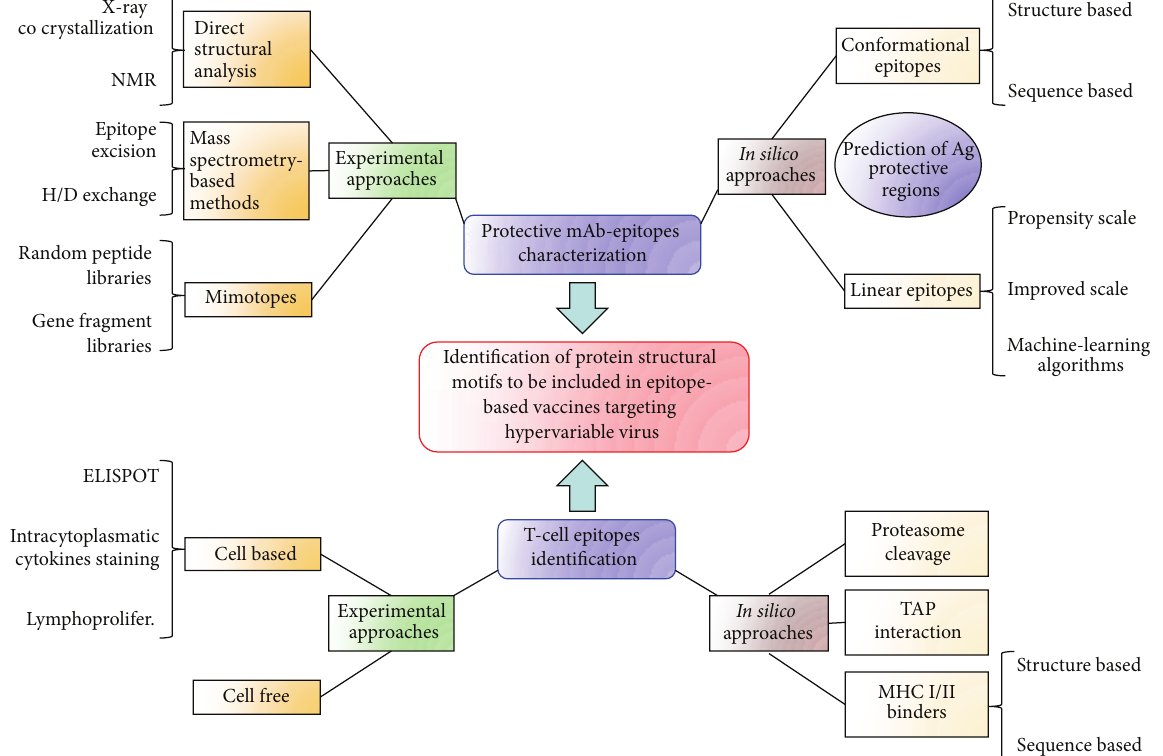
Figure 1: The described approaches to characterize protein structural motifs to be included in new vaccines targeting hypervariable viruses. The synergistic use of techniques combining experimental and in silico approaches is also